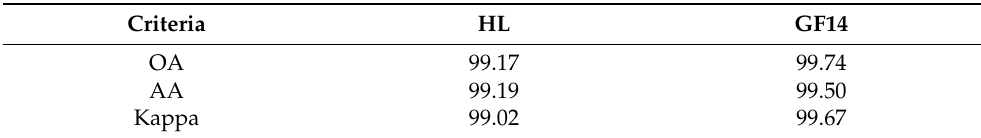
Table 5. Classification results (%) by selecting 90% labeled samples.